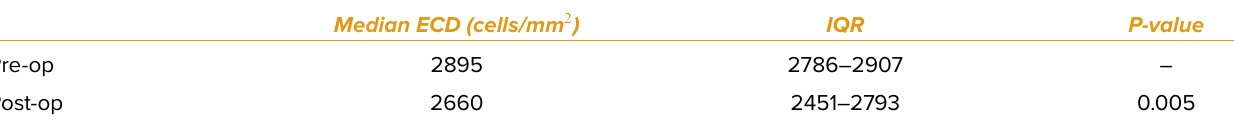
Table 3. Analysis of endothelial cell density before and after hypotonic collagen